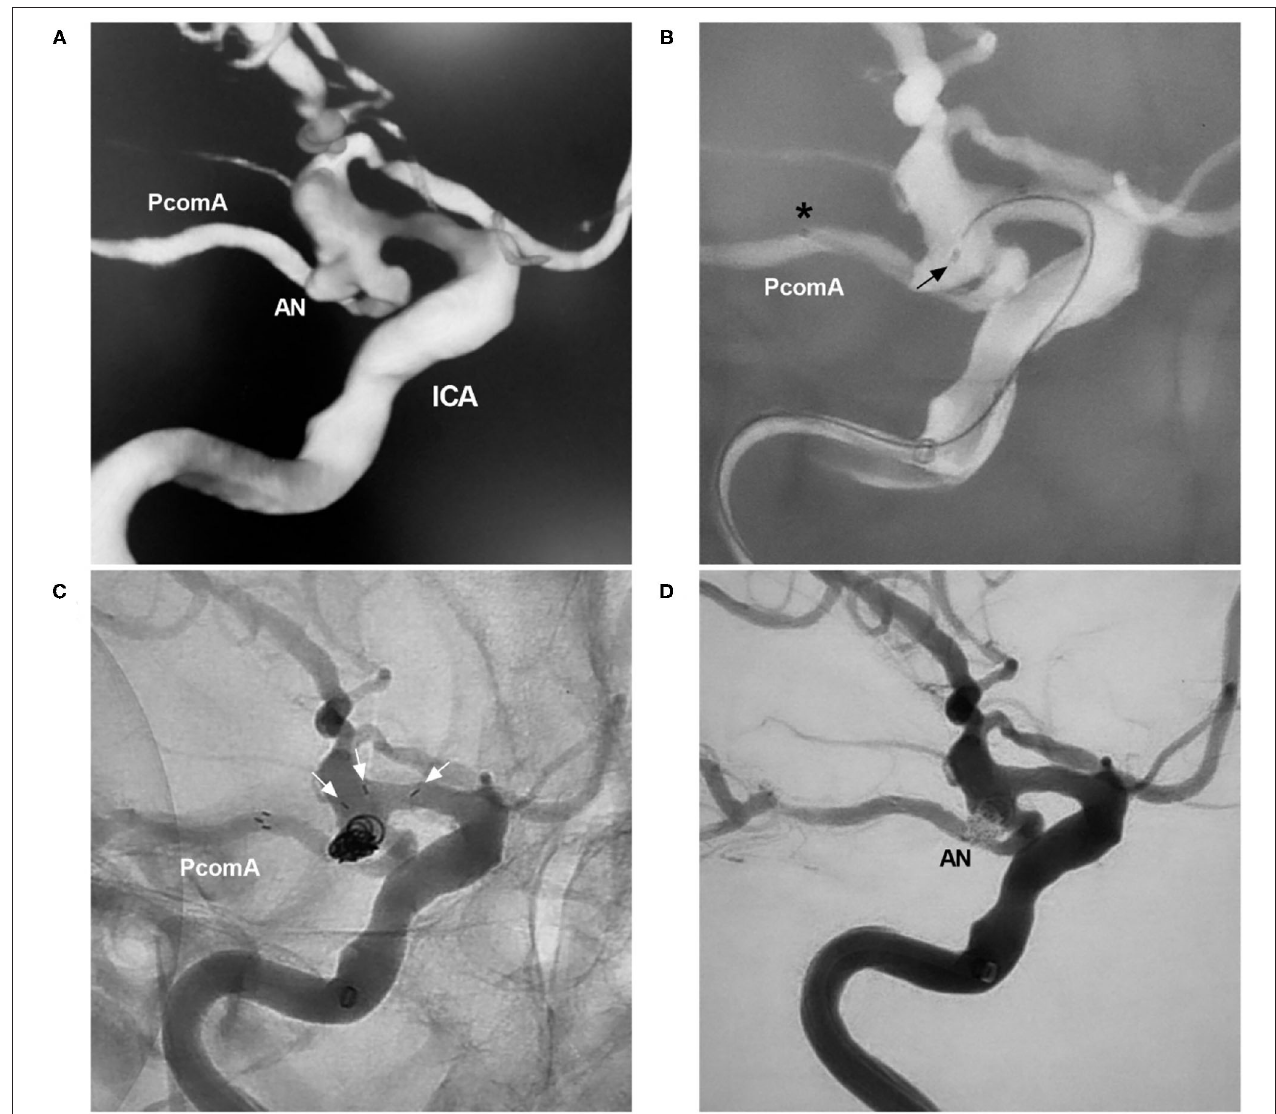
FIGURE 8 | NAS-assisted coiling of a PcomA aneurysm. (A) Three-dimensional DSA of the ICA showing a PcomA aneurysm (AN). (B) Map showing the positioning of the NAS delivery microcatheter (the asterisk shows the distal marker) and the coil delivery microcatheter (the arrow shows the tip). (C) Unsubtracted DSA showing the opening of the proximal NAS segment (the arrows show three proximal markers) in the ICA. (D) Postoperative DSA of the ICA showing Raymond-Roy class 1 embolization of the aneurysm (AN). AN, aneurysm; DSA, digital subtraction angiography; ICA, internal carotid artery; PcomA, posterior communicating artery; NAS, Neuroform Atlas